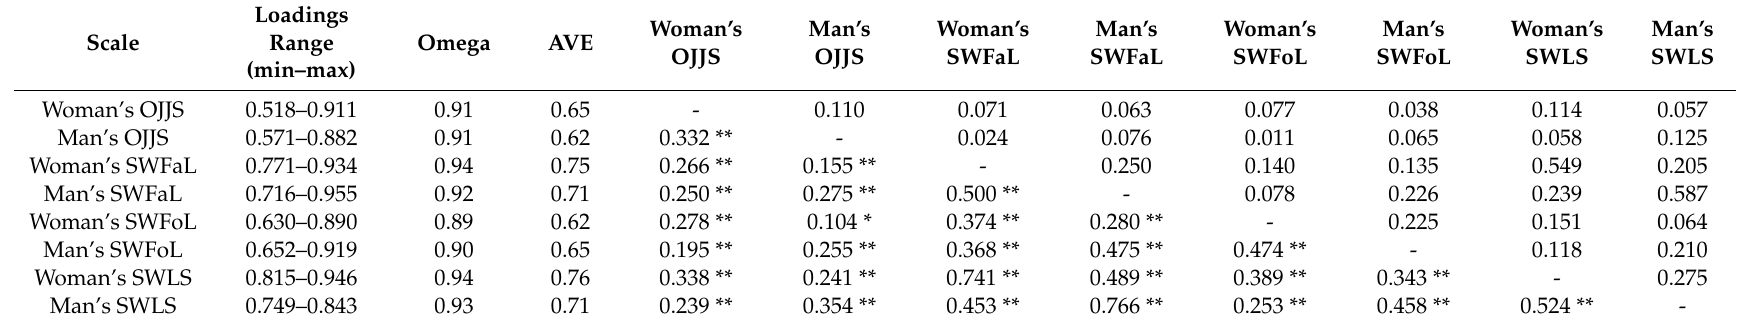
Table 2. Factor loadings range, Omega coe ffi cients, average variance extracted (AVE), correlations and squared correlations between the Overall Job Satisfaction Scale (OJSS), Satisfaction with Family life scale (SWFaL), Satisfaction with Food-related Life scale (SWFoL) and Satisfaction with Life Scale (SWLS) scores for each member of the